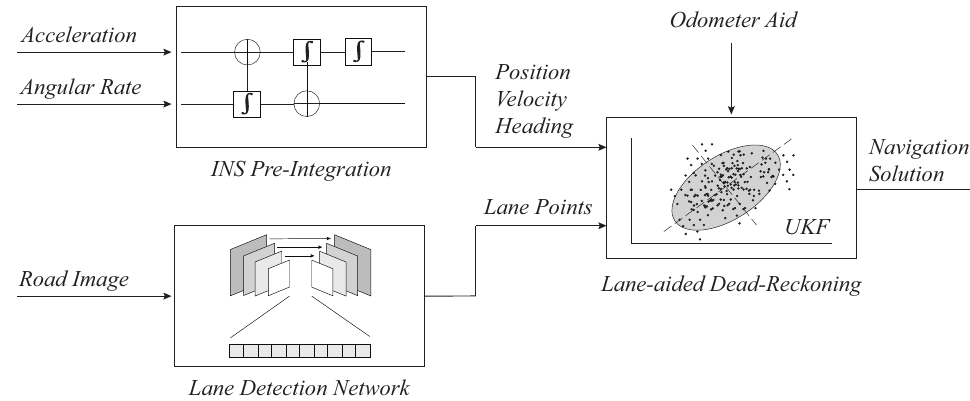
Figure 2. Overall architecture of land-aided dead-reckoning